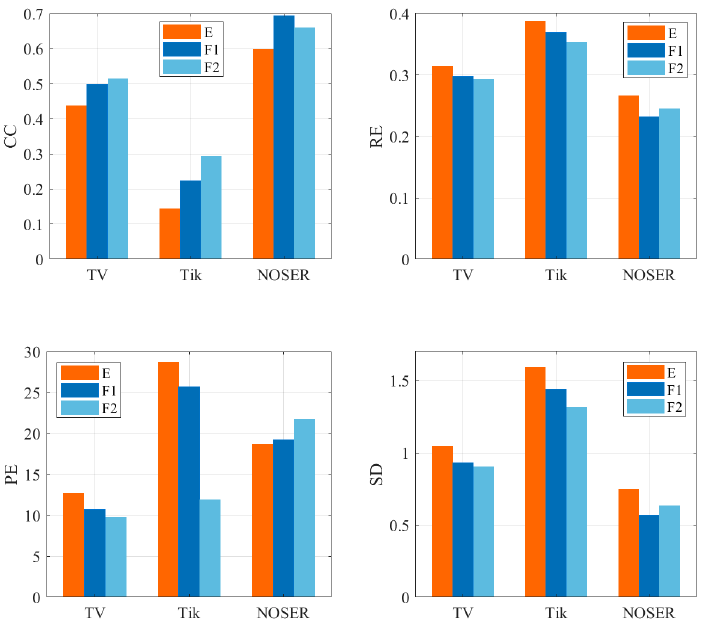
Figure 7. Quantitative analysis of the reconstruction